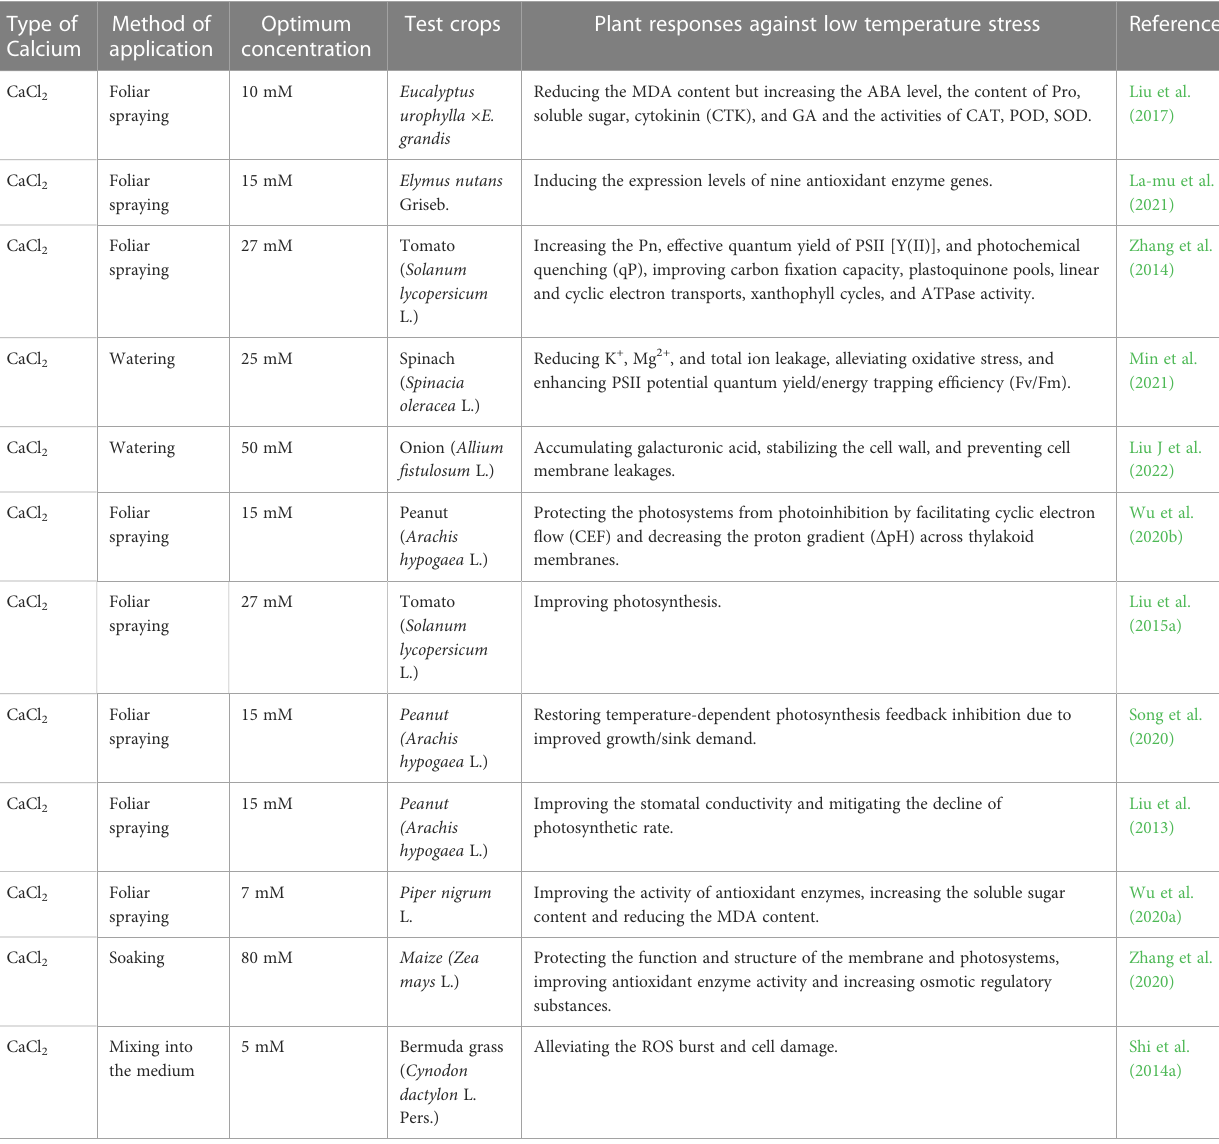
TABLE 5 List of optimal concentrations of exogenous calcium used to alleviate low temperature stress in different